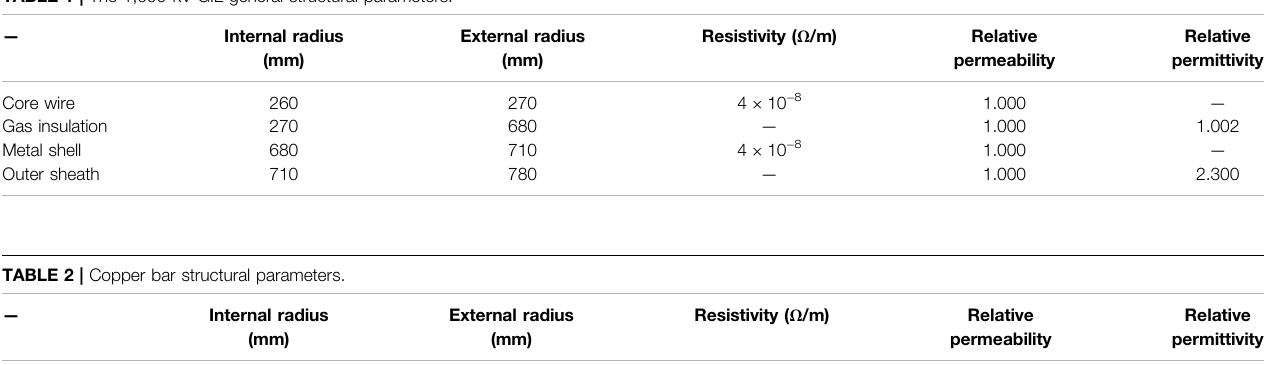
TABLE 1 | The 1,000-kV GIL general structural parameters.